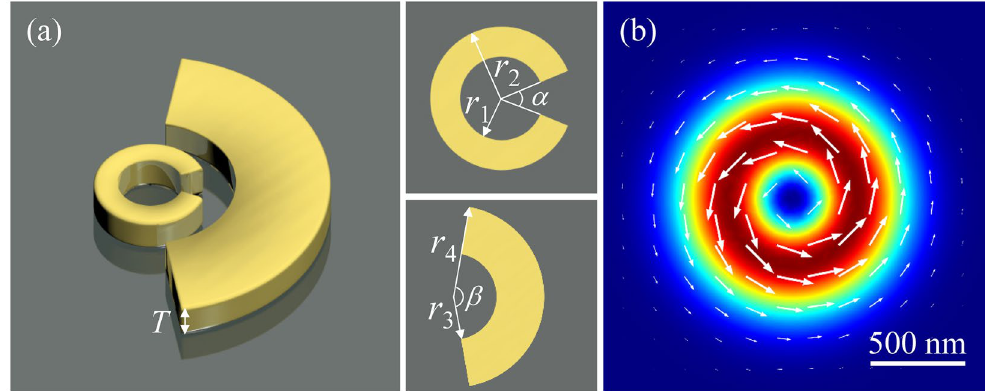
Figure 1. ( a ) Schematic view of the split-ring resonator (SRR) and nanoarc combined structure with the geometry parameters: r 1 , r 2 , r 3 , r 4 , α , β and T . ( b ) Intensity and electric vector distributions of an azimuthally polarized beam